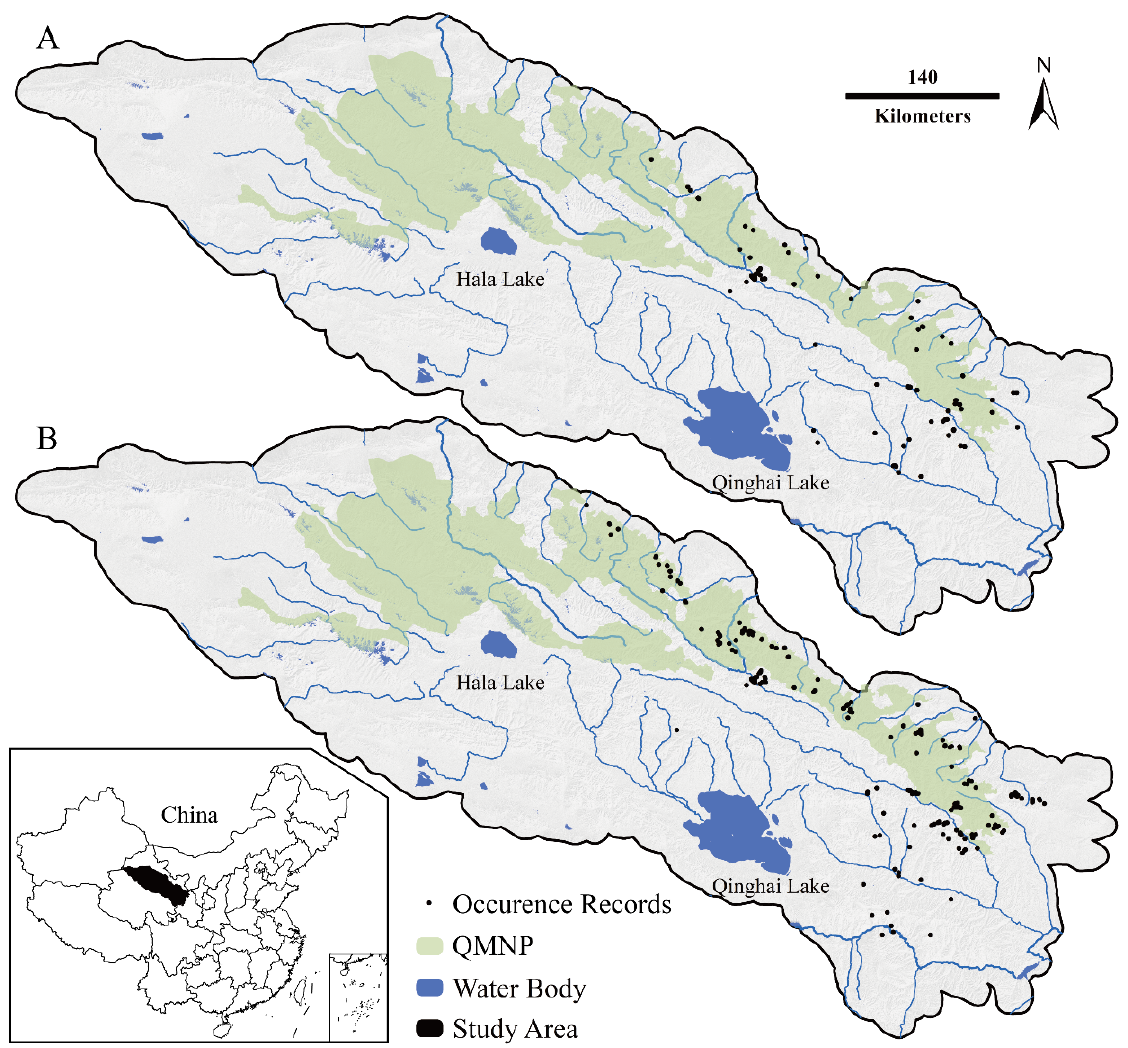
Figure 1. Species occurrence sites (the black spots) for blood pheasant ( A ) and blue eared pheasant ( B ). The range of the QMNP is highlighted in green. The administrative border of China was derived from the Standard Map Service: GS(2019)1686.